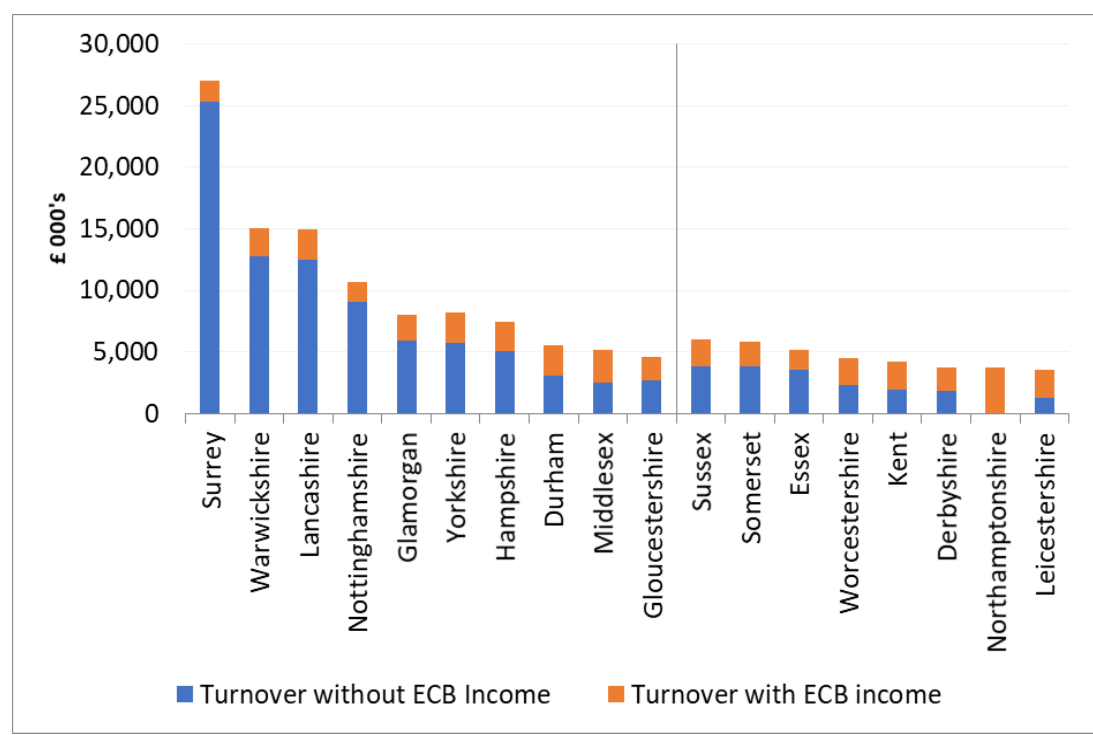
Figure 2. Average ‘earned’ vs. ‘unearned’ income in £000s (2014 – 2016).